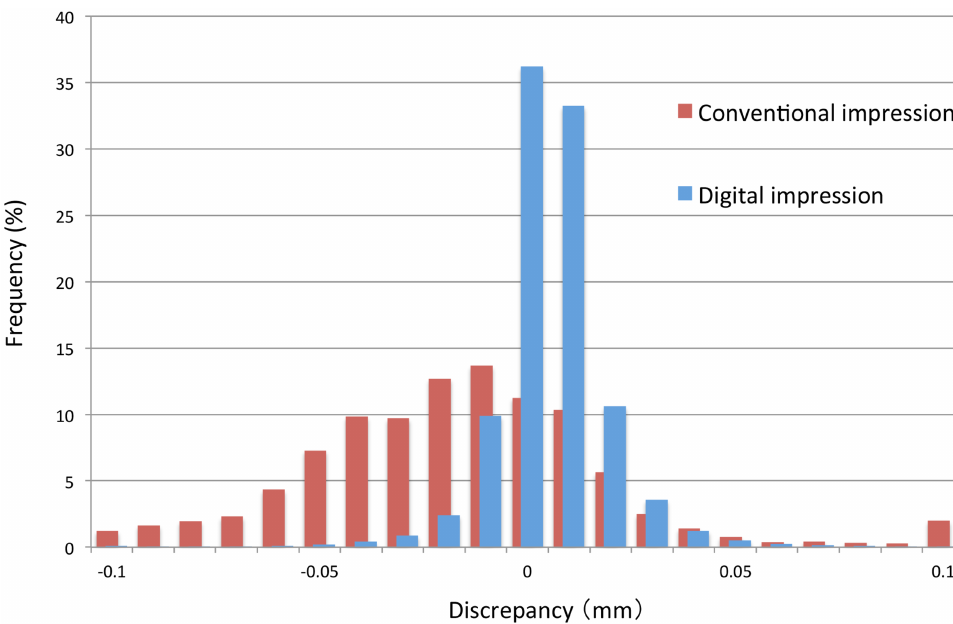
Fig 4. Distribution of dimensional discrepancies between repeated measurements by the 2 different operators for each impression technique (Participant a). Distributionof discrepancy concentrated on zero for the digital impressiontechniquewhen compared with the conventional impressiontechnique.